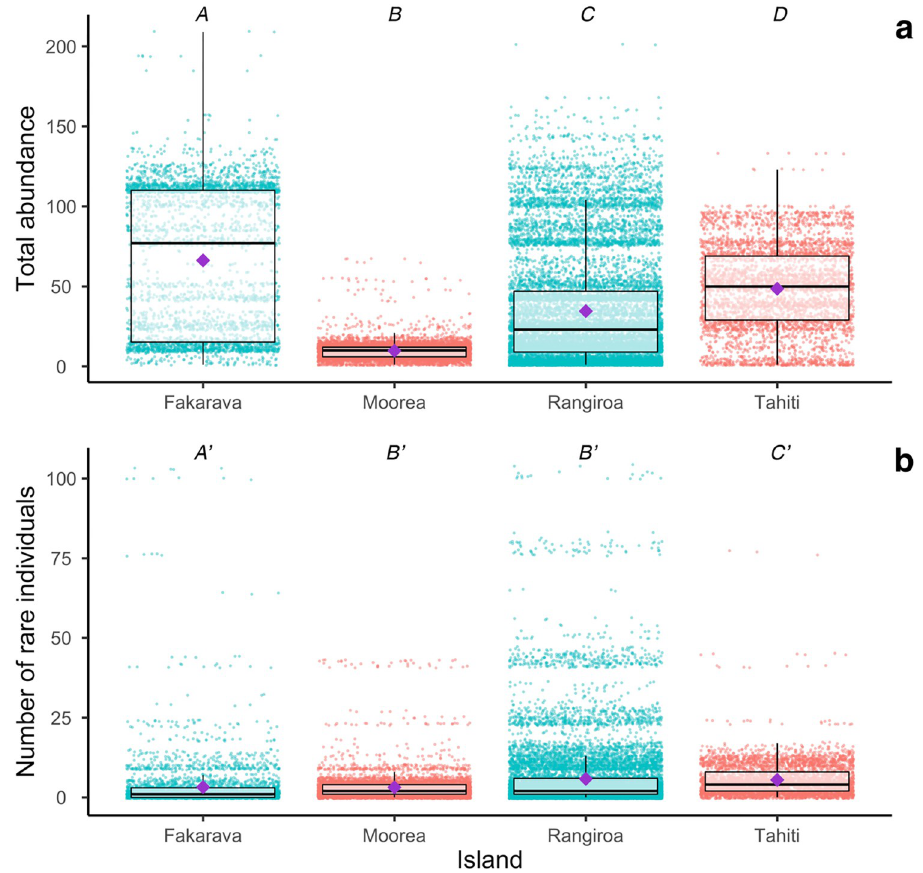
Fig 9. Difference of (a) total abundance; (b) elasmobranchs from rare species abundance between the four more sampled islands. Blue and red dots respectively represent dives conducted in Tuamotu and Society islands. Boxplots sharing different letters are significantly different in pairwise comparisons (p-value < 0,05). Purple dots represent mean values of the variable for the island considered. Note y-axis scale varies between